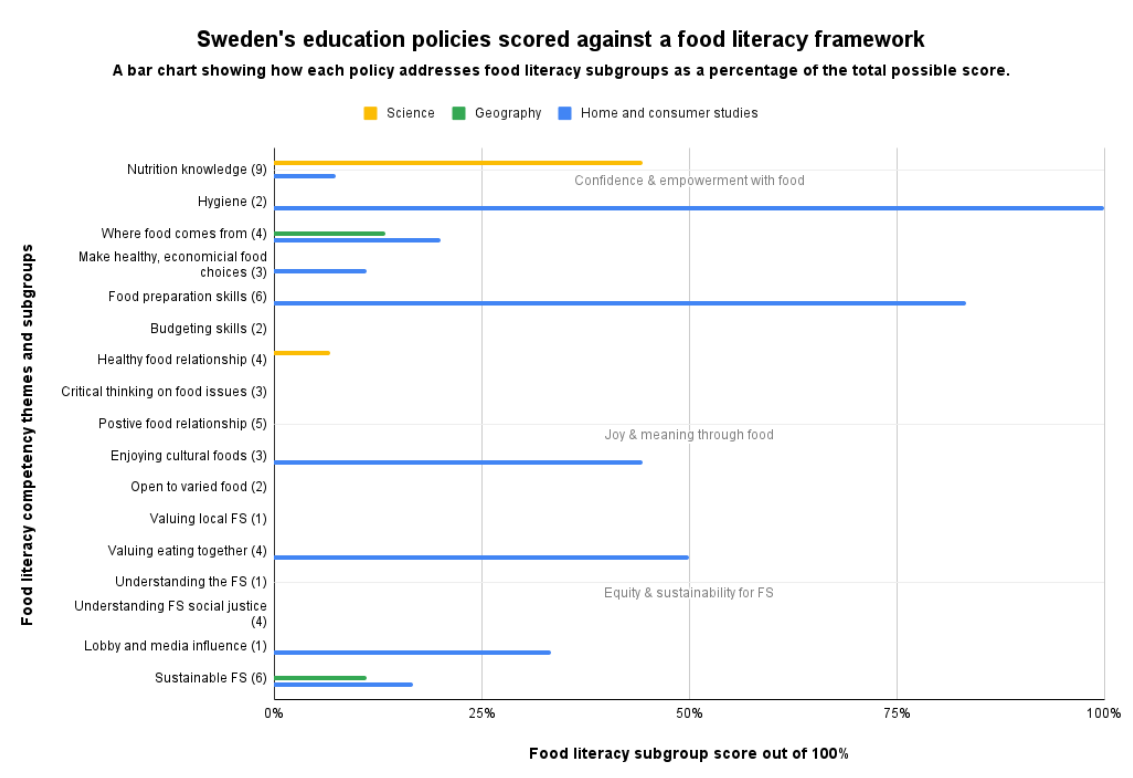
Figure 4. Overview of how 11 countries address FL. Confidence and Empowerment with Food, Joy and Meaning Through Food, and Equity and Sustainability for Food Systems refers to FL framework themes. Source: authors.